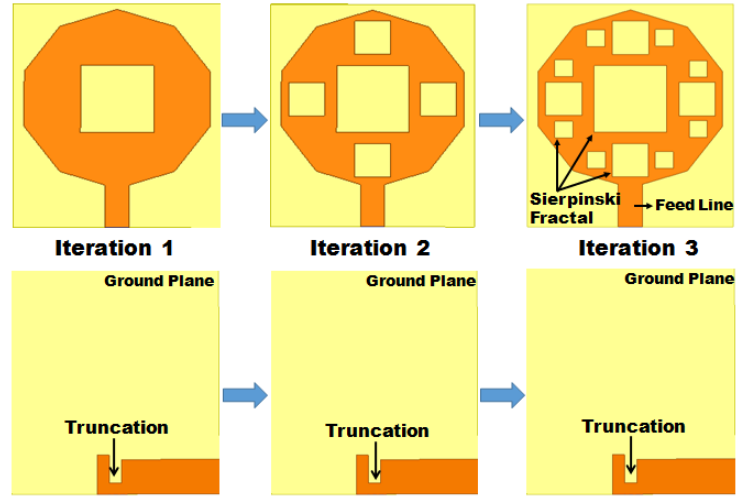
Figure 4. Progression stages of UWB antenna.